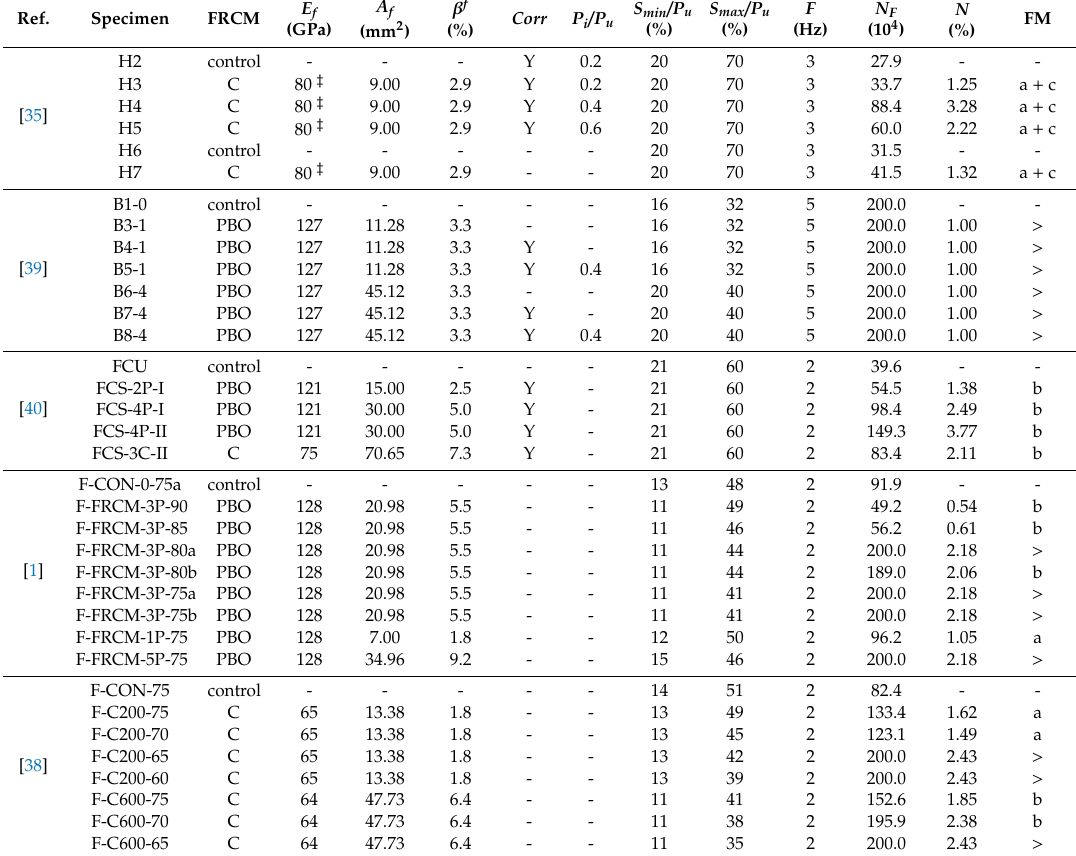
Table 2. Main parameters and results of the experimental tests compiled.